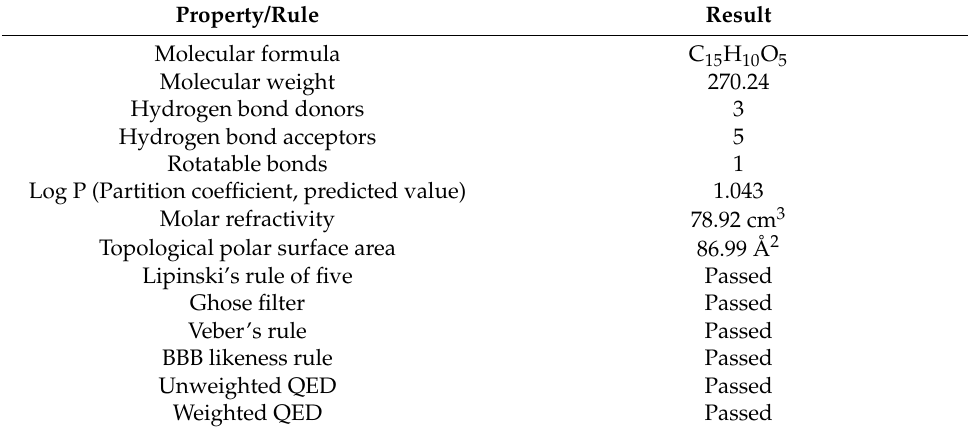
Table 2. Physicochemical and drug-likeness properties of genistein.